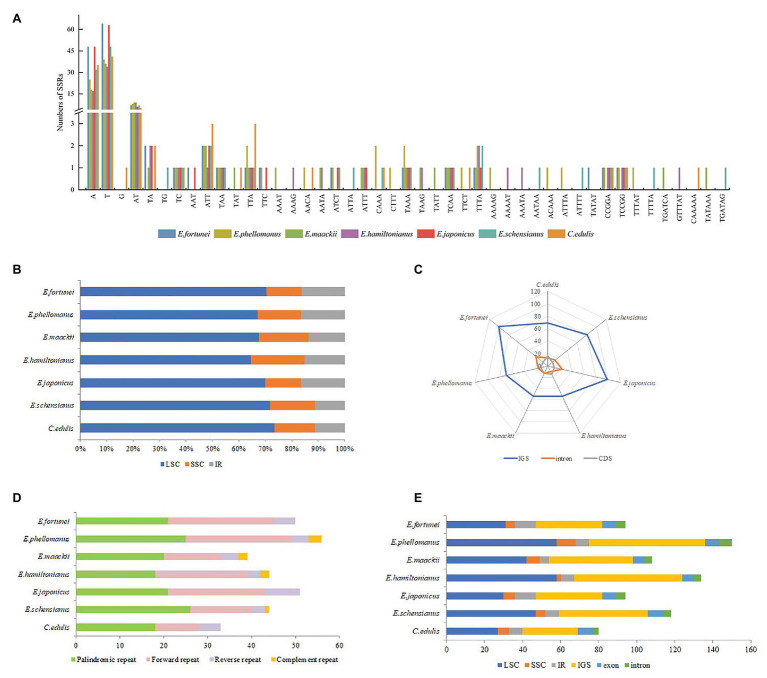
(A) Analysis of simple-sequence repeats (SSRs) in the chloroplast genomes of seven Celastraceae species; (B) Frequency of SSRs in the LSC, IR, SSC region; (C) Frequency of SSRs in the intergenic regions, protein-coding genes, and introns; (D) Number of Palindromic repeat, Direct repeat, Reverse repeat, Complement repeat; (E) Distribution of tandem repeats in genomic regions and exon, intergenic spacer (IGS), and intron regions.